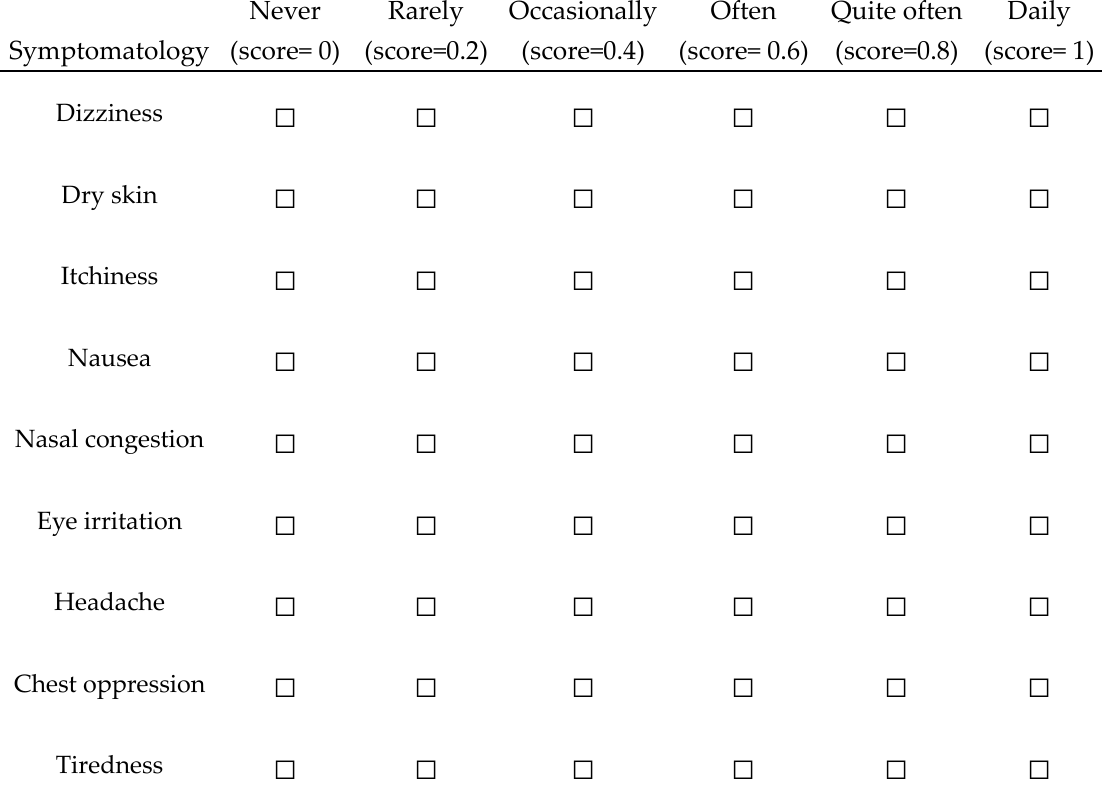
Figure 3. Extract from student survey